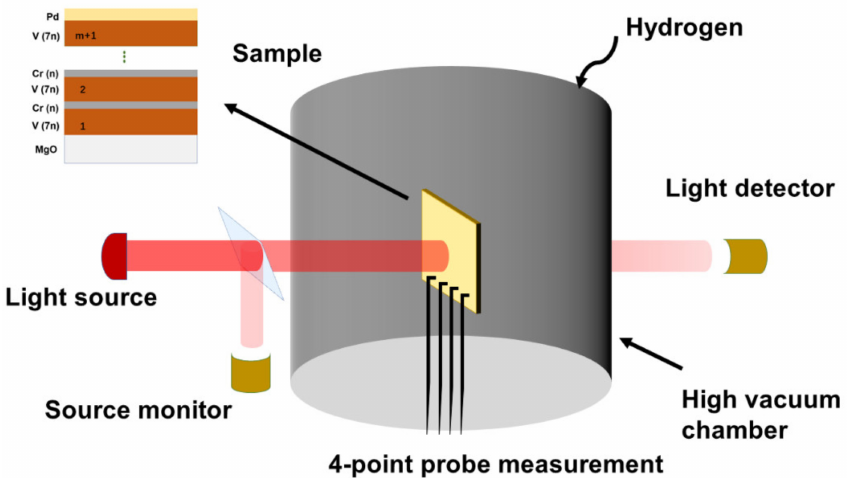
Figure 1. Schematics of the experimental setup. Light transmission is used to determine the hydrogen content while a four-point probe technique is used to measure the electrical properties. The left upper corner of the figure is the sample